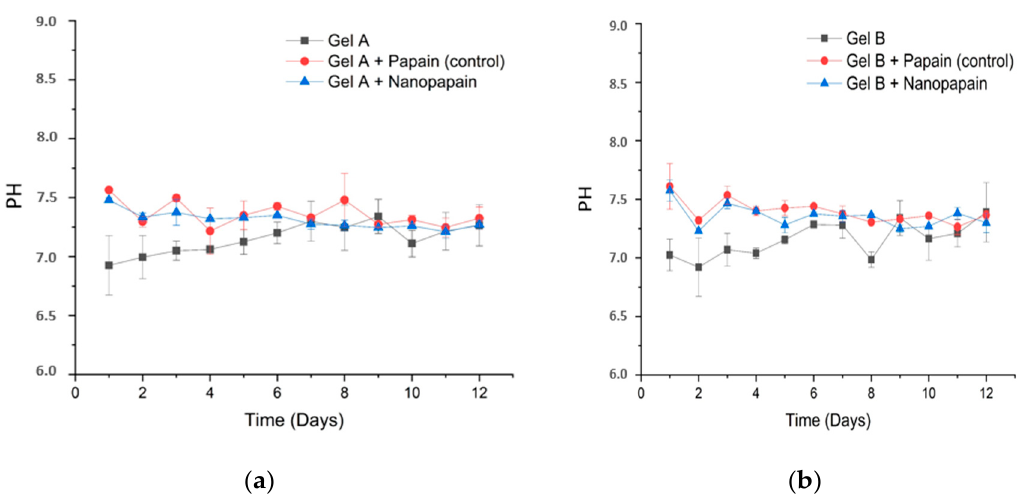
Figure 2. pH measured during stability assessment for the prototype formulations A ( a ) and B ( b ). All measurements were performed by diluting the gels to 5% ( v / v ).